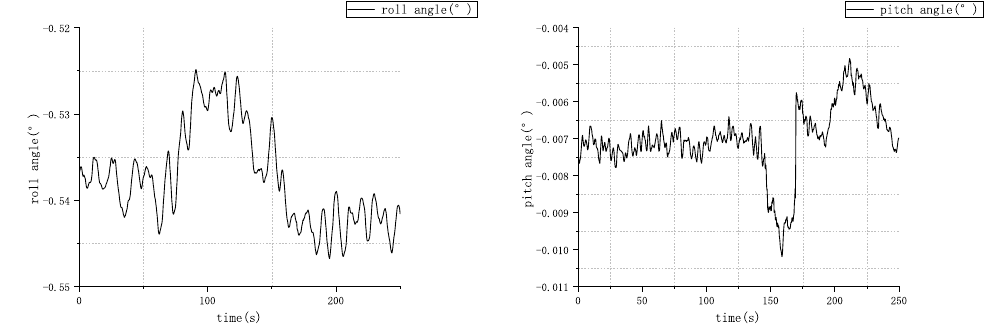
Figure 6. Dataset 1: The raw roll and pitch angle of the